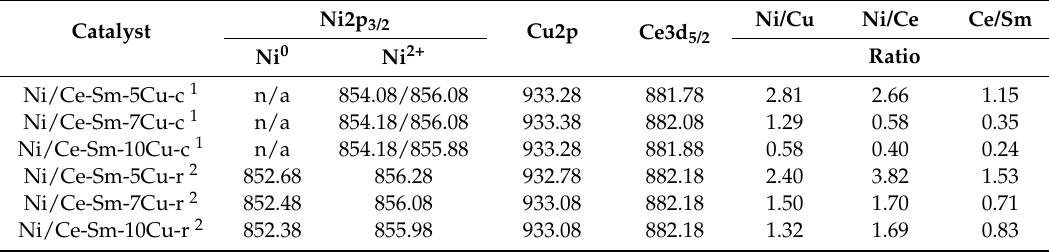
Figure 6. Core level spectra of: ( a ) Ni2p, ( b ) Cu2p; ( c ) Ce and ( d ) Sm3d, respectively of the reduced Ni/Ce-Sm-xCu catalysts. Table 2. Binding energies (eV) of the elements and surface atomic ratios based on the x-ray photoelectron spectroscopy (XPS)